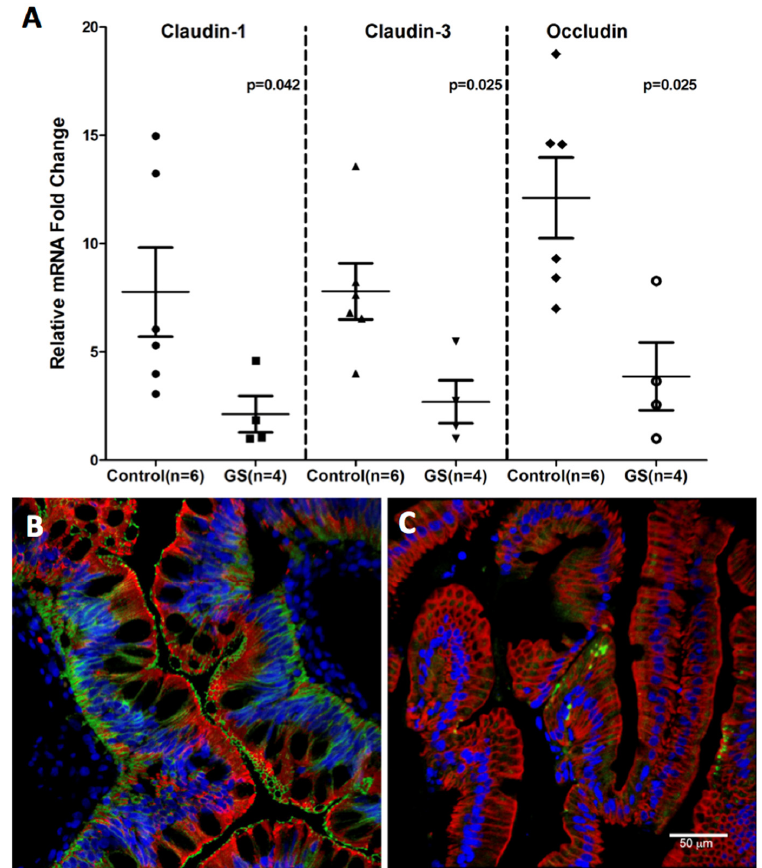
Figure 8. Tight junction protein expression in jejunum of GS macaques. mRNA expression of Claudin ‐ 1, ‐ 3 and Occludin is significantly decreased ( p < 0.05) in jejunum of GS ( n = 4) relative to normal healthy control macaques ( n = 6) ( A ); Data was normalized to a combination of three endogenous controls (Beta ‐ Actin, 18S rRNA, GAPDH) and analyzed using non ‐ parametric Wilcoxon’s rank sum test for independent samples. The error bars represent standard error of mean fold change within each group. While Claudin ‐ 1 ( green ) protein is well expressed in jejunum epithelial cells ( red ) from normal healthy macaque ( B ); its signal is very low or absent in jejunum from GS animal ( C ). Both B and C panels are triple labels with claudin ‐ 1 in green , cytokeratin in red and nuclear labeling with Topro3 in blue .